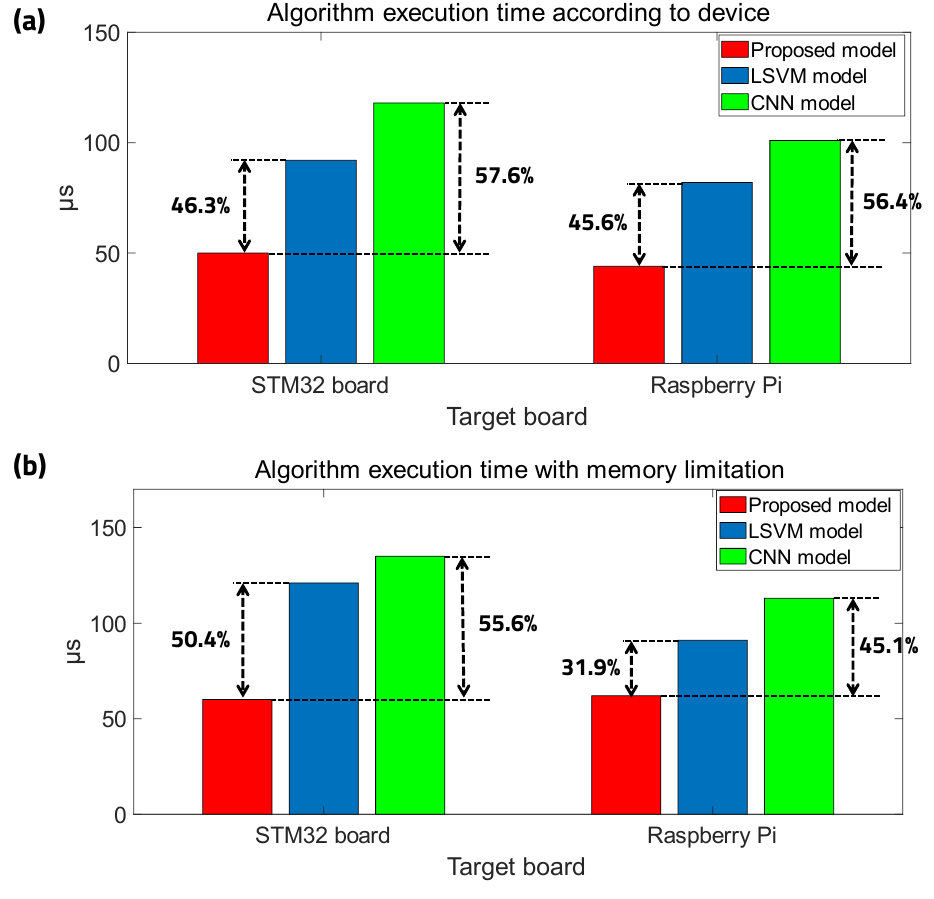
Figure 14. ( a ) Execution time of each algorithm. ( b ) Execution time of each algorithm with mem- ory